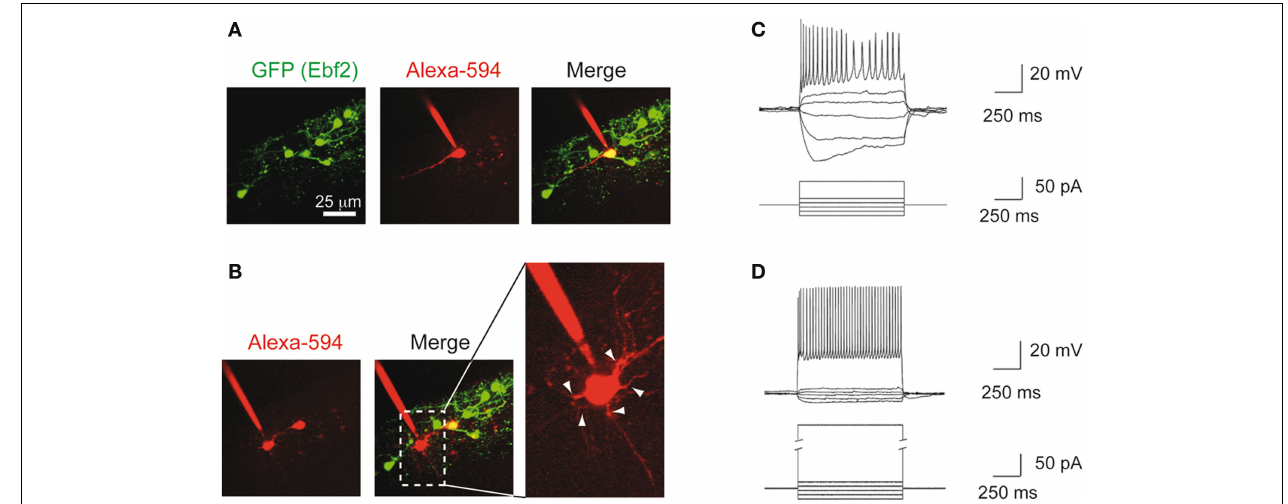
soma of this cell (akin to the cells labeled by white arrows in Figures 2A,C ). (C) Current clamp recording of a typical GFP + cell showing broad action potentials with adaptation and a sag in the hyperpolarizing response, characteristic of CR neurons. (D) Current clamp recording of a fast spiking